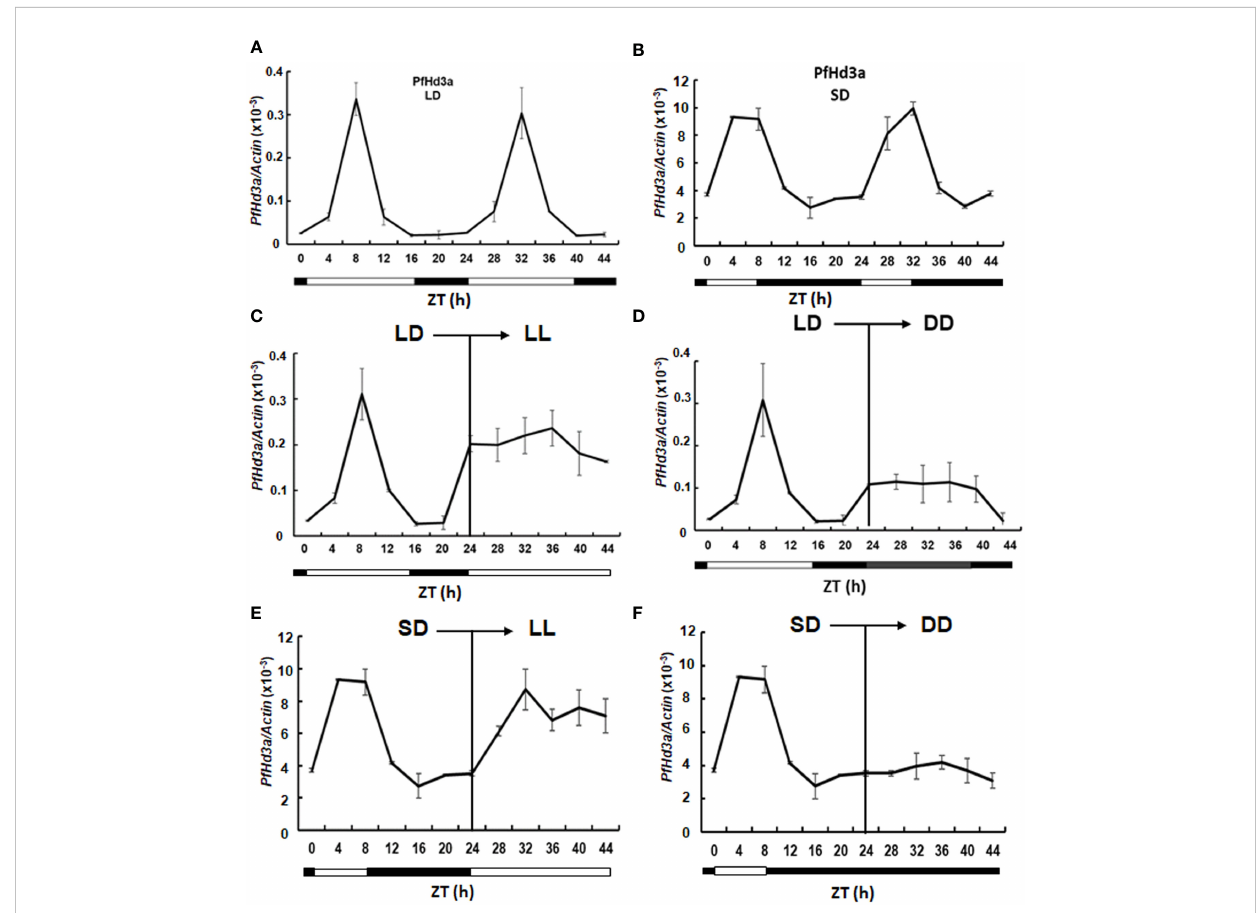
FIGURE 2 Expression analysis of PfHd3a . Rhythmic expression of PfHd3a under LD (A) and SD (B) . Expression analysis of PfHd3a under continuous light (LL) continuous dark (DD). The perillas were grown in growth chambers under LD (16 h light/8 darkness) and then transferred to LL (C) or DD (D) conditions. The perillas were grown in growth chambers under SD (8 h light/16 darkness) and then transferred to LL (E) or DD (F) conditions. White bars indicated light; black bars indicate darkness. The perilla actin gene was used as the internal control. Values represent means ± Standard deviation (SD) from two independent biological